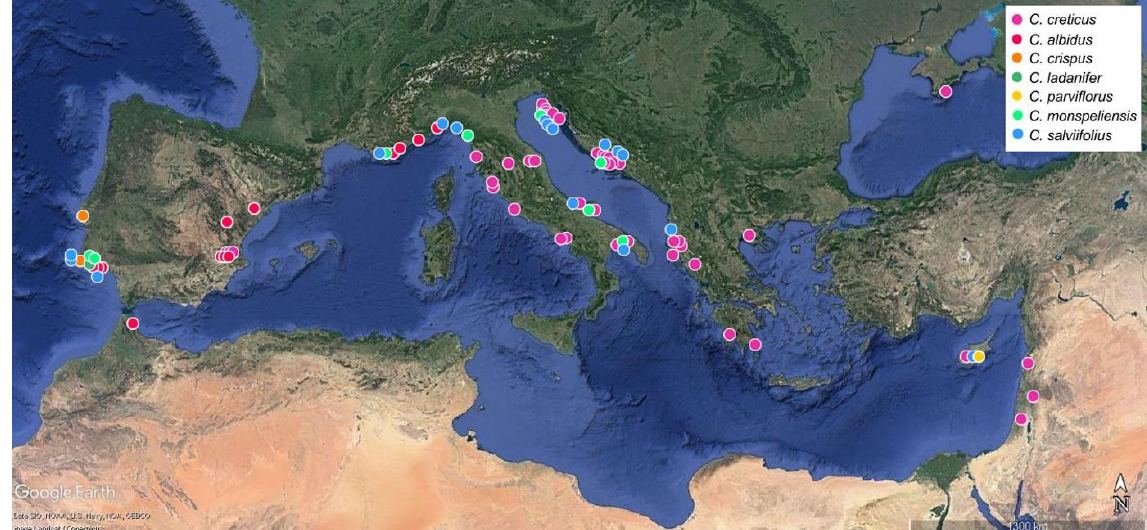
Figure 4. Geographical origin of the Cistus populations analyzed (distribution map was compiled with Google Earth (https://www.google.com/earth/download/ (accessed on 12 March 2020)). The three marks in Cyprus represent the 29 populations of C. creticus , eight populations of C. parviflorus and seven populations of C. salviifolius sampled (mainly) in Southern Cyprus. Geographical coordinates are summarized in Table S1, Supplementary Material.